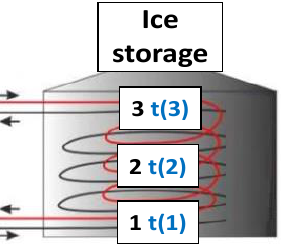
Figure 5. Ice storage tank.